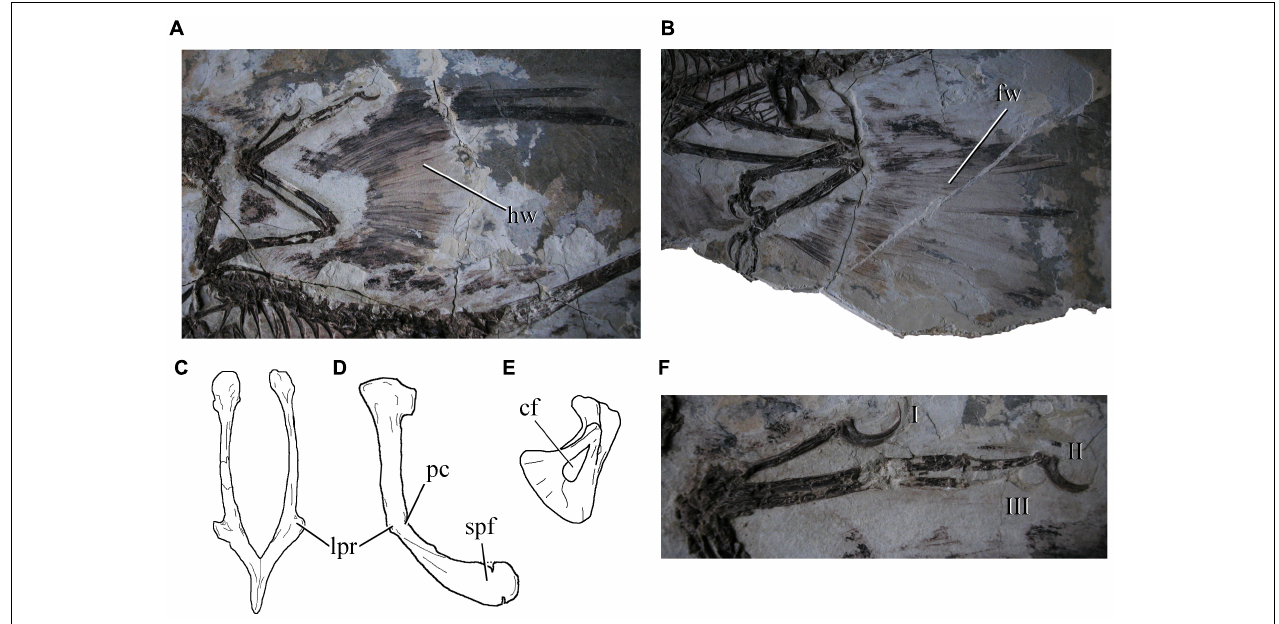
FIGURE 4 | Selected microraptorian traits: (A) feathered hindlimb and (B) feathered forelimbs of Microraptor zhaoianus (IVPP V123352); pubis in anterior (C) and lateral (D) views of Hesperornychus elizabethae (redrawn from Longrich and Currie, 2009) showing the lateral process, posterior flexure of shaft and spatulate pubic foot; (E) coracoid of Sinornithosaurus millenii showing the coracoid fenestra (modified from Xu, 2002); and (F) left manus of Microraptor zhaoianus (IVPP V123352). cf, coracoid fenestra; fw, forelimb wing; hw, hindlimb wing; lpr, lateral process of pubis; pc, posterior concavity; spf, spatulate pubic foot. Not to scale.